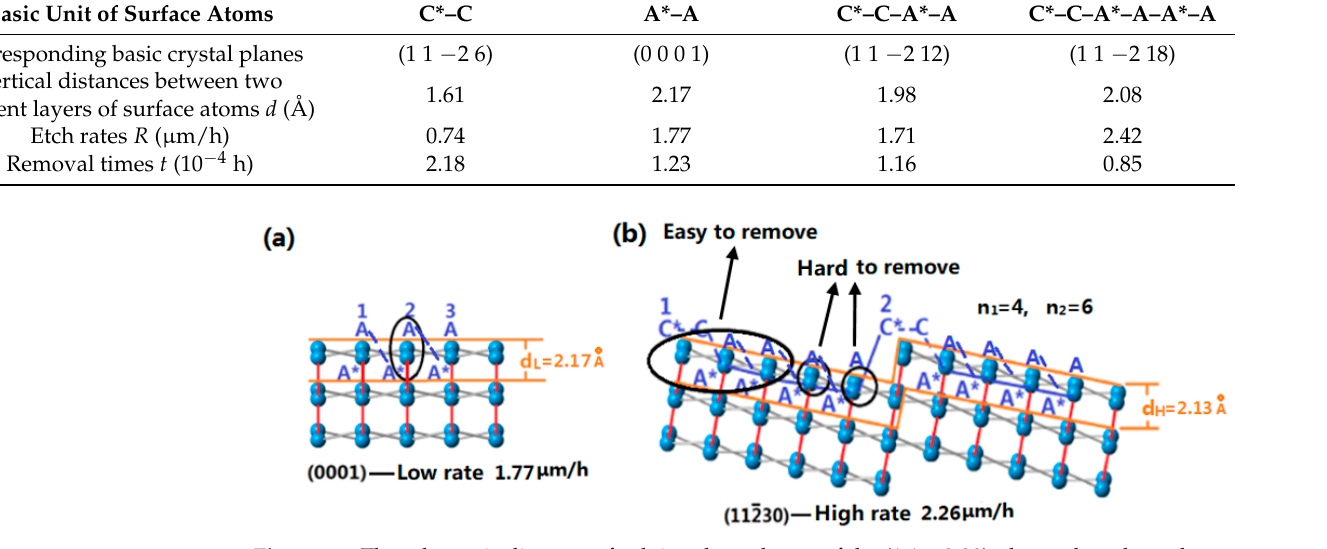
Figure 11. The schematic diagram of solving the etch rate of the (1 1 − 2 30) plane when the etch